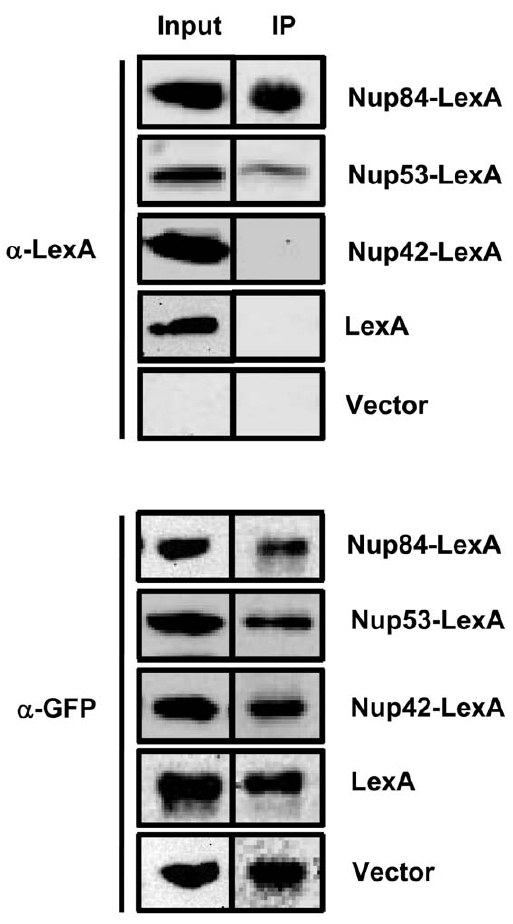
Figure 3. Mig1 interacts with the Nup84 subcomplex. First lane (Input) shows the presence of the expressed proteins in the cell lysates; second lane (IP)shows the presenceor absence of LexA-tagged proteins in the immunoprecipitated samples (top panel), and the immunoprecipita- tion of GFP-tagged Mig1 with the anti-GFP antibody in all the conditions tested (bottom panel). Vector, sample without any LexA-tagged Table 2). In all other mutants tested, there was a strong correlation (R 2 = 0.93) between loss of SUC2 repression, shown as an increase in invertase levels, and the fraction of Mig1 associated with NPCs (Fig. 4, Table 2); as Mig1 is lost from the perinuclear sub- compartment, inhibition of SUC2 expression is lost exponentially (Fig. S3). This was not due to an overall reduction in levels of the Mig1 protein, which were no lower than in wild type cells (Fig. 4, Fig. 5, and Table 2). In fact, there was an inverse relationship (R 2 = 0.72) between the amount of Mig1 present in the nucleus of these mutants and the degree of SUC2 repression (Table 2).